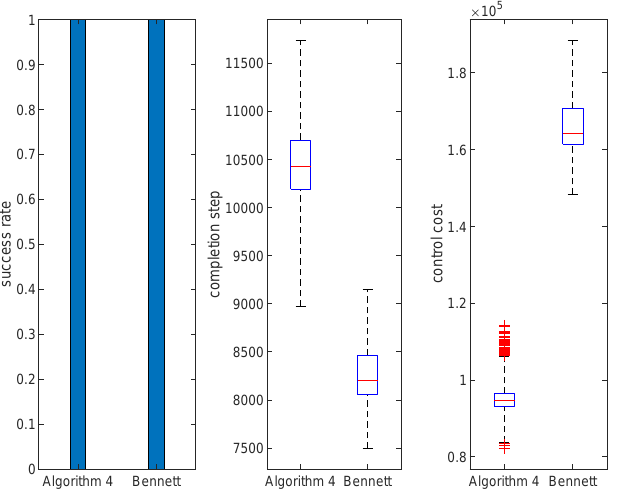
Figure 14. Results comparing Algorithm 4 with Bennett’s